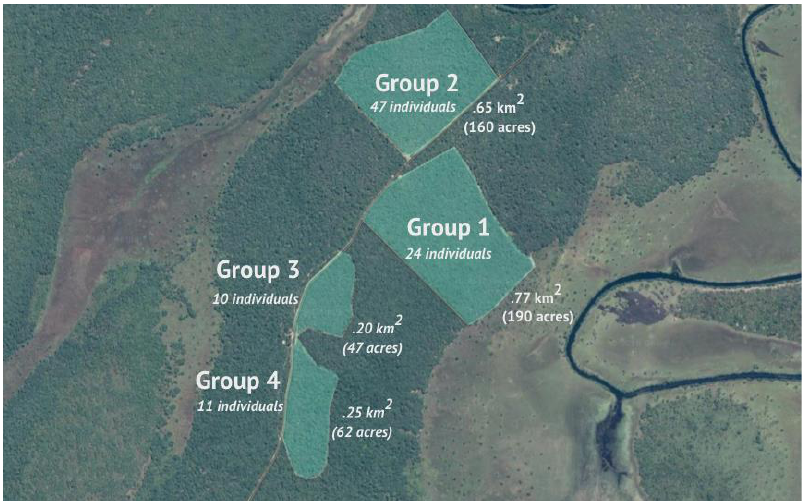
Figure 1. Aerial view of the Project area at the Chimfunshi Wildlife Orphanage Trust in Zambia. Upon arriving at the sanctuary (average age 3.2 years), the rescued chimpanzees were typically placed under human care for a short period of time, after which they were